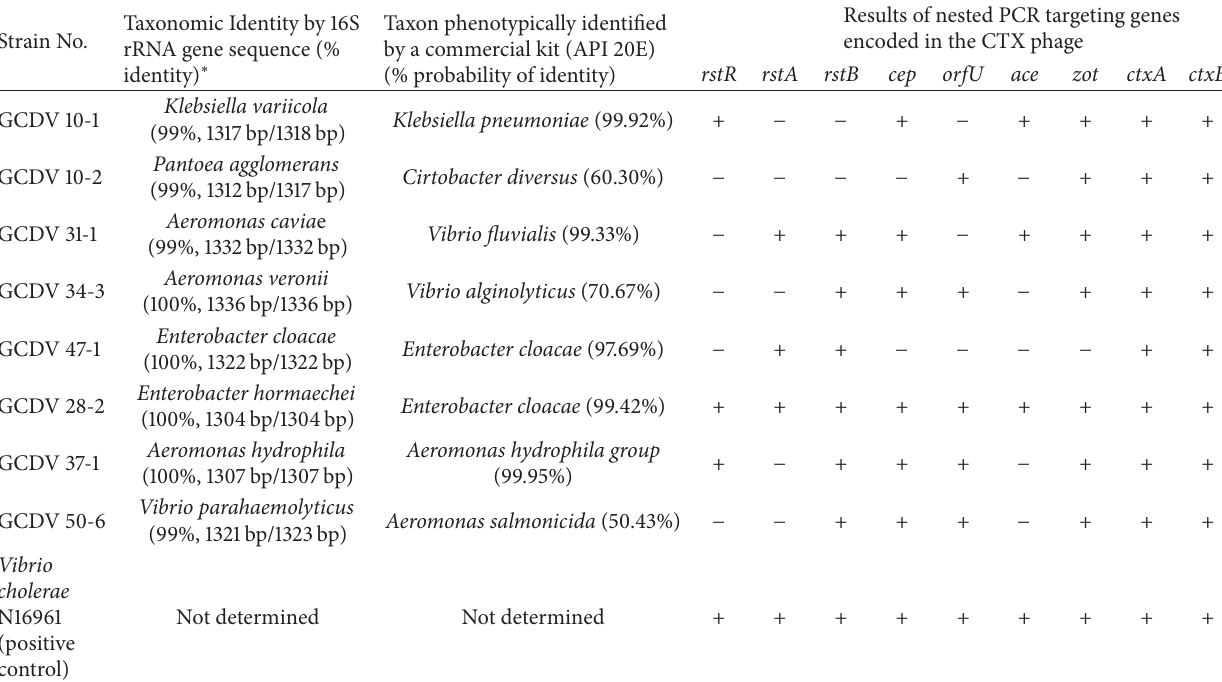
Table 2: Tentative taxonomic identity of cholera toxin gene carrying environmental bacterial isolates based on their 16S rRNA gene sequences and biochemical characteristics and distribution of CTX phage encoded genes in each isolate. Strain No.